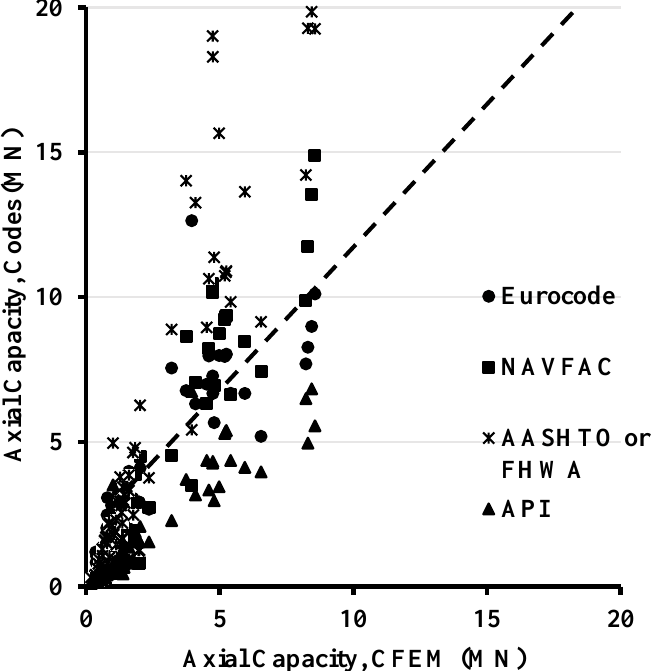
Figure 1. Comparison between results of other design codes and the theoretical axial capacity in driven piles determined using the CFEM method.